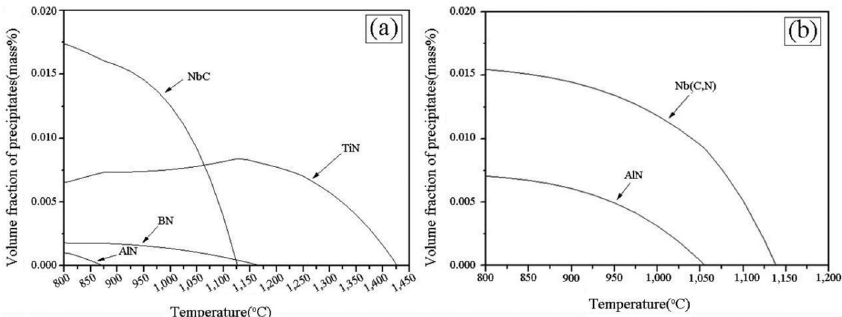
Figure 7: Equilibrium precipitation predicted by Thermol-Calc for (a) steel A and (b) steel B.